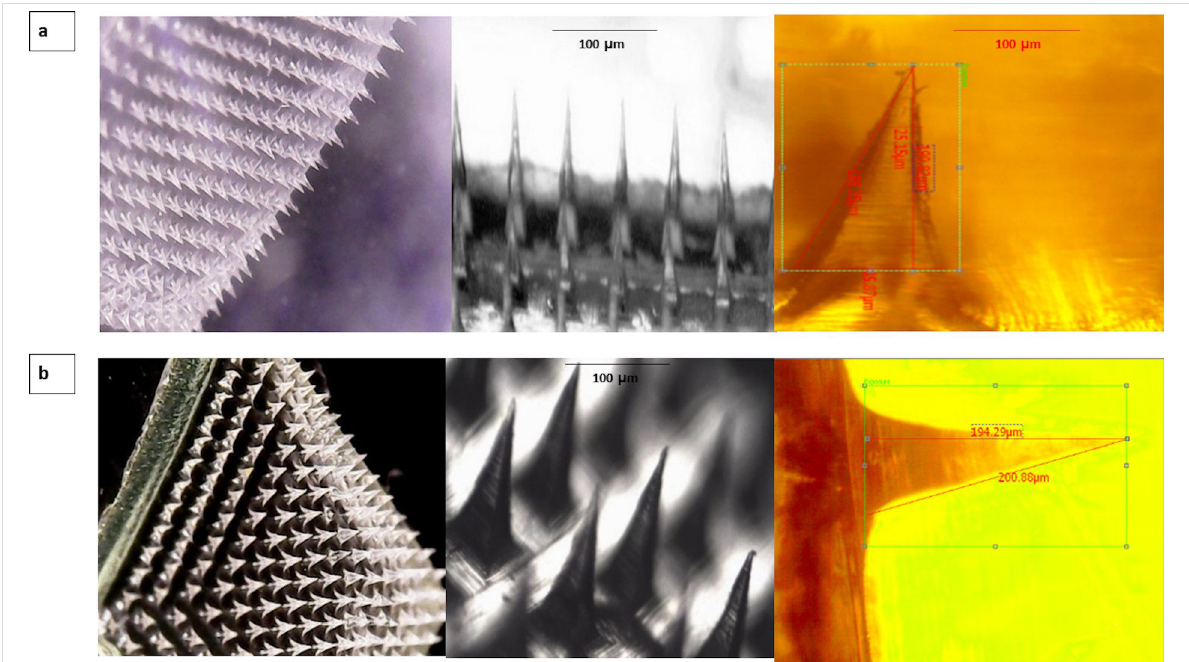
Figure 4: Microneedle visualization for two formulations; (a) CIP_MN1 images under digital light microscope, and (b) CIP_MN2 images under digital light microscope.